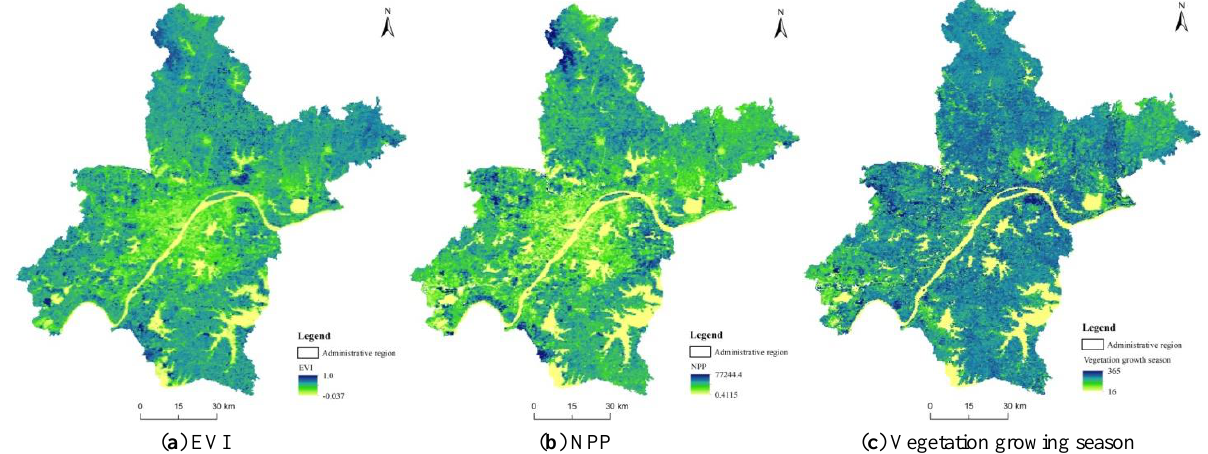
Figure 2. Spatial patterns of vegetation’s EVI, NPP and growing